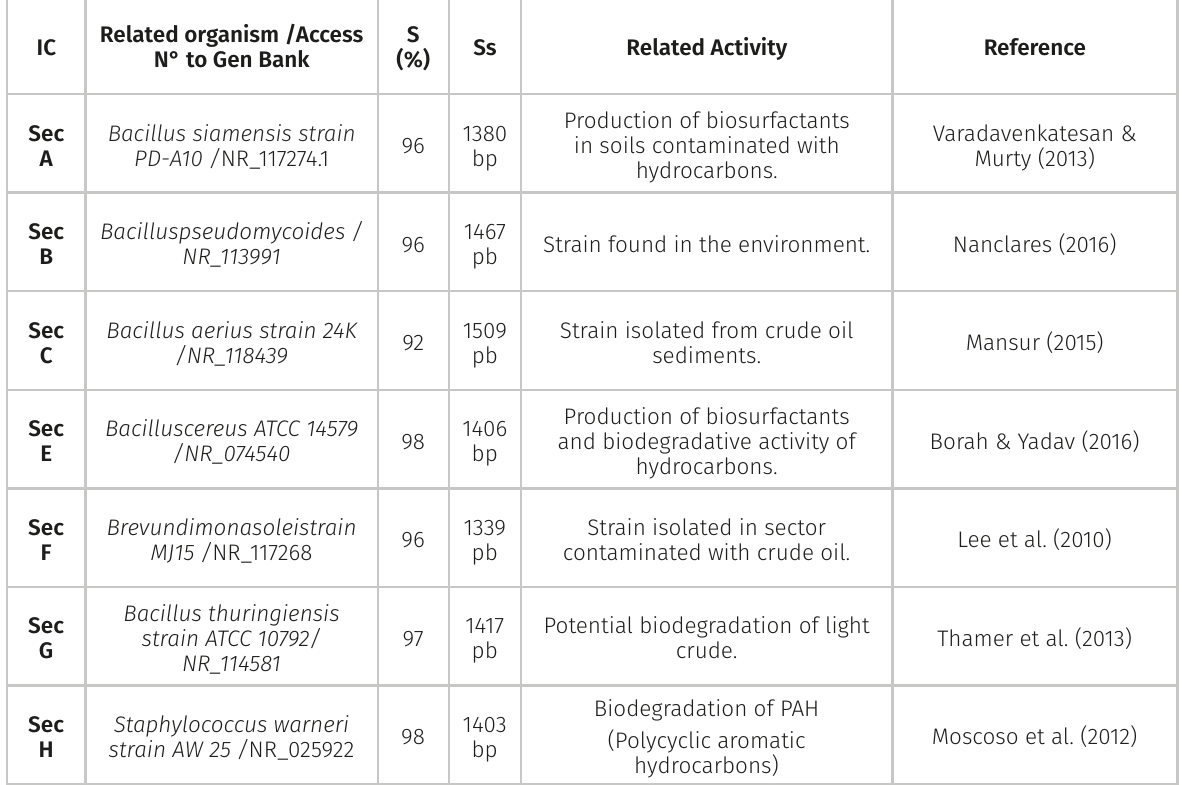
Table II. Molecular identification of bacteria isolated from treatment bioremediation soils (BI, BII, BIII y BS) using 16S rRNA